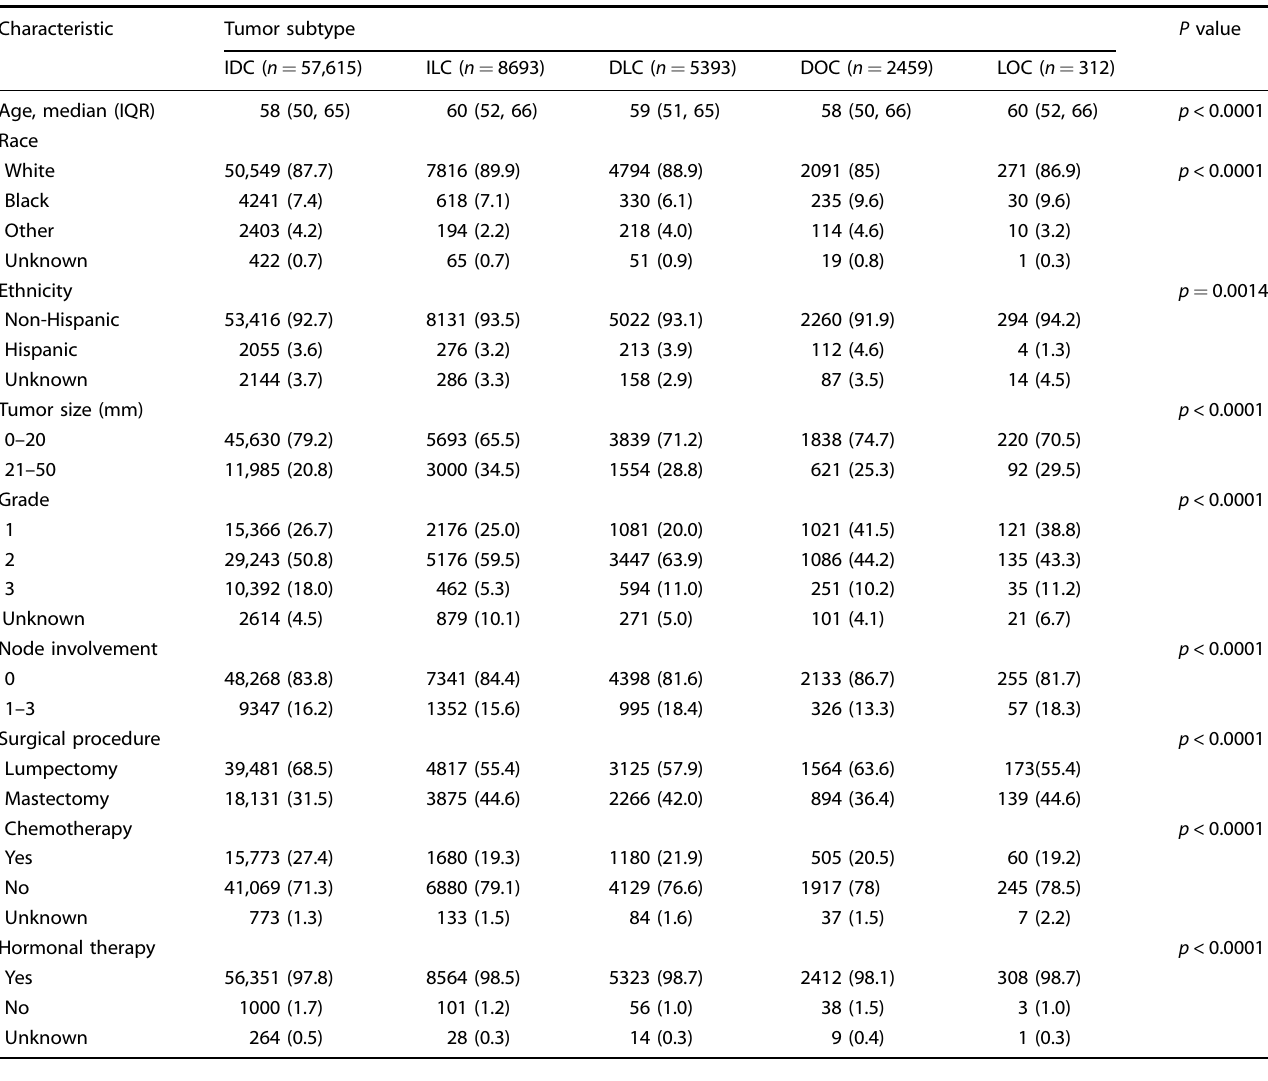
Table 1. Patient characteristics.